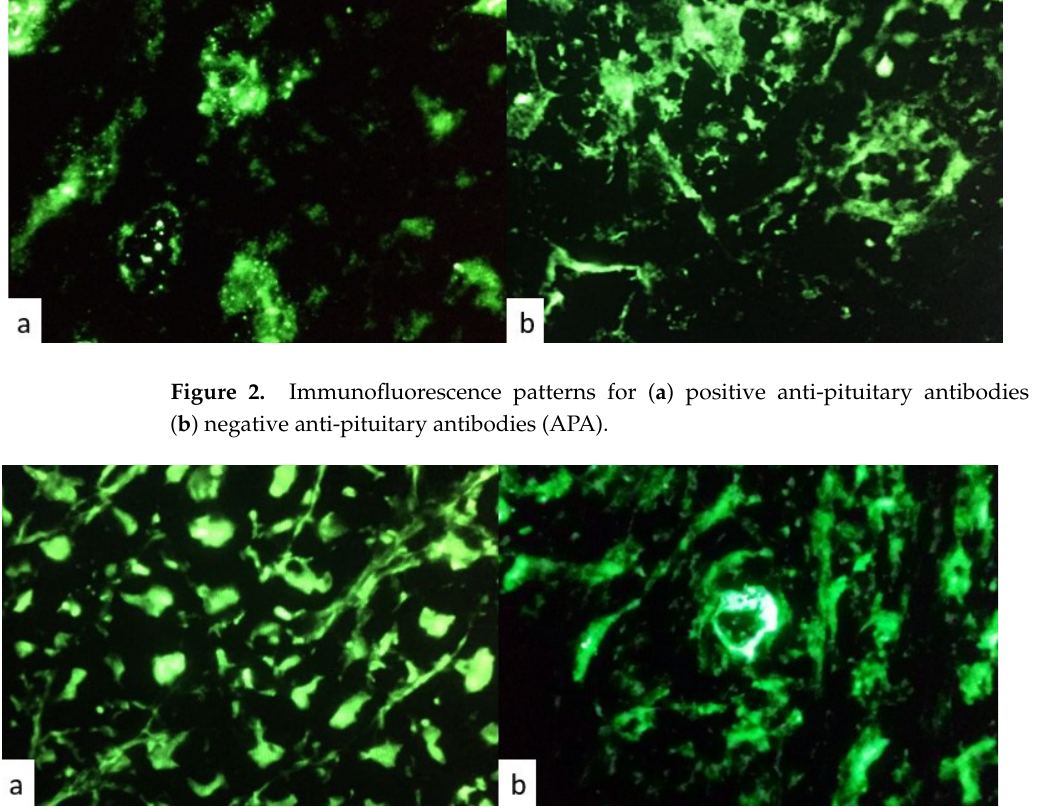
Figure 3. Immunofluorescence patterns for ( a ) positive anti-hypothalamus antibodies (AHA) and ( b ) negative anti-hypothalamus antibodies (AHA).